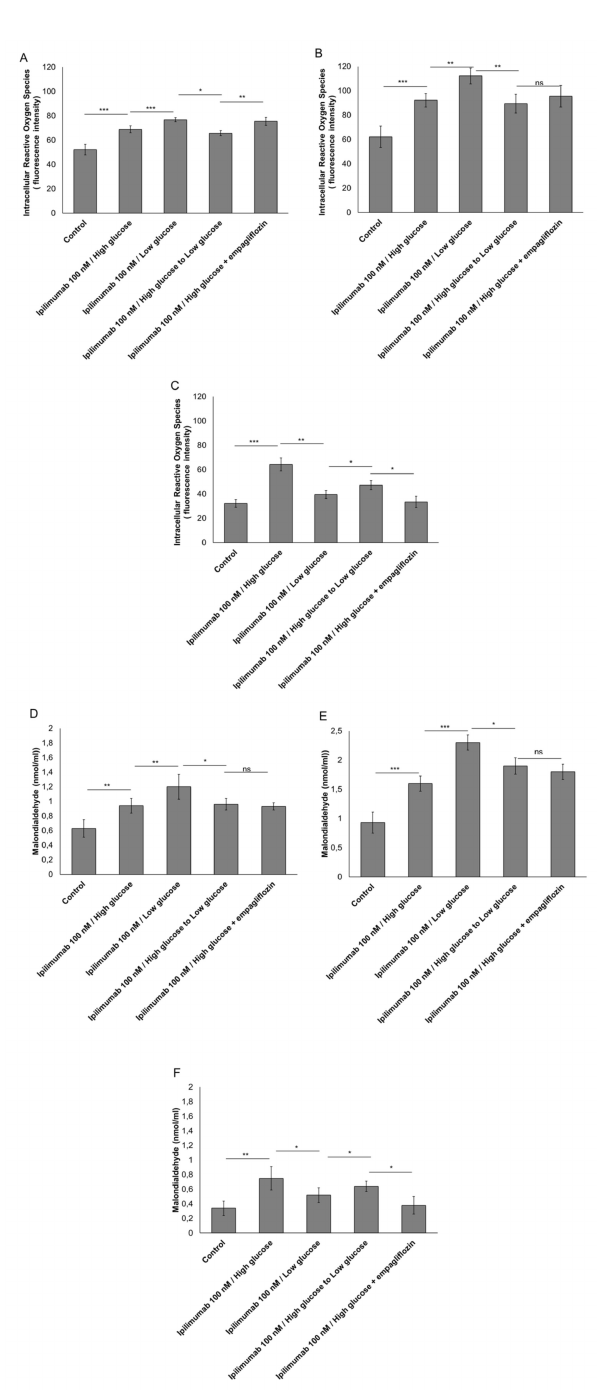
Figure 4. Intracellular Reactive Oxygen Species (ROS) and Malondialdeyde (MDA) quantification in MCF-7 cells ( A , D ) and MDA-MB-231 ( B , E ) cells treated with ipilimumab mAb in the presence of hPBMCs under di ff erent condition (high glucose; low glucose; high glucose + empagliflozin at 50 nm; shifting from a high glucose to low glucose). Untreated or treated cells with an unrelated control IgG (control) were used as negative controls; ( C , F ) Intracellular Reactive Oxygen Species (ROS) and Malondialdeyde (MDA) quantification in AC-16 cells, treated with ipilimumab mAb for 24 h, in the presence of hPBMCs under di ff erent conditions (high glucose; low glucose; high glucose + empagliflozin at 500 nM; shifting from a high glucose to low glucose). Untreated or treated cells with an unrelated control IgG (control) were used as negative controls. Error bars depict means ± SD ( n = 3). Statistical analysis was performed using paired t -test. *** p < 0.001. ** p < 0.01. * p <